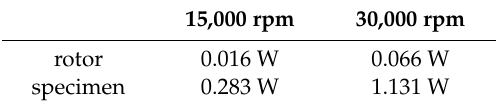
Table 2. Air friction losses in the test rig with p = 0.05 Pa and T = 290 K.